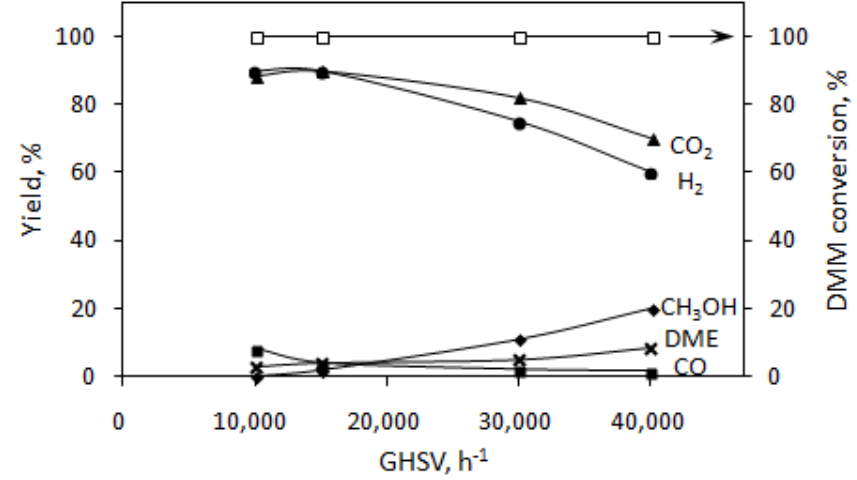
E ff ect of GHSV on catalyst performance in DMM oxidative steam reforming over CuO-CeO 2 / γ -Al 2 O 3 catalyst. Reaction conditions: P = 1 atm; T = 300 ◦ C; Inlet composition: Figure 6. Effect of GHSV on catalyst performance in DMM oxidative steam reforming over DMM:O 2 :H 2 O:N 2 = 10:2.5:40:47.5 СuO-CeO 2 /γ-Al 2 O 3 catalyst. Reaction conditions: P = 1 atm; Т = 300 °C; Inlet composition: DMM:O 2 :H 2 O:N 2 = 10:2.5:40:47.5 vol.%.